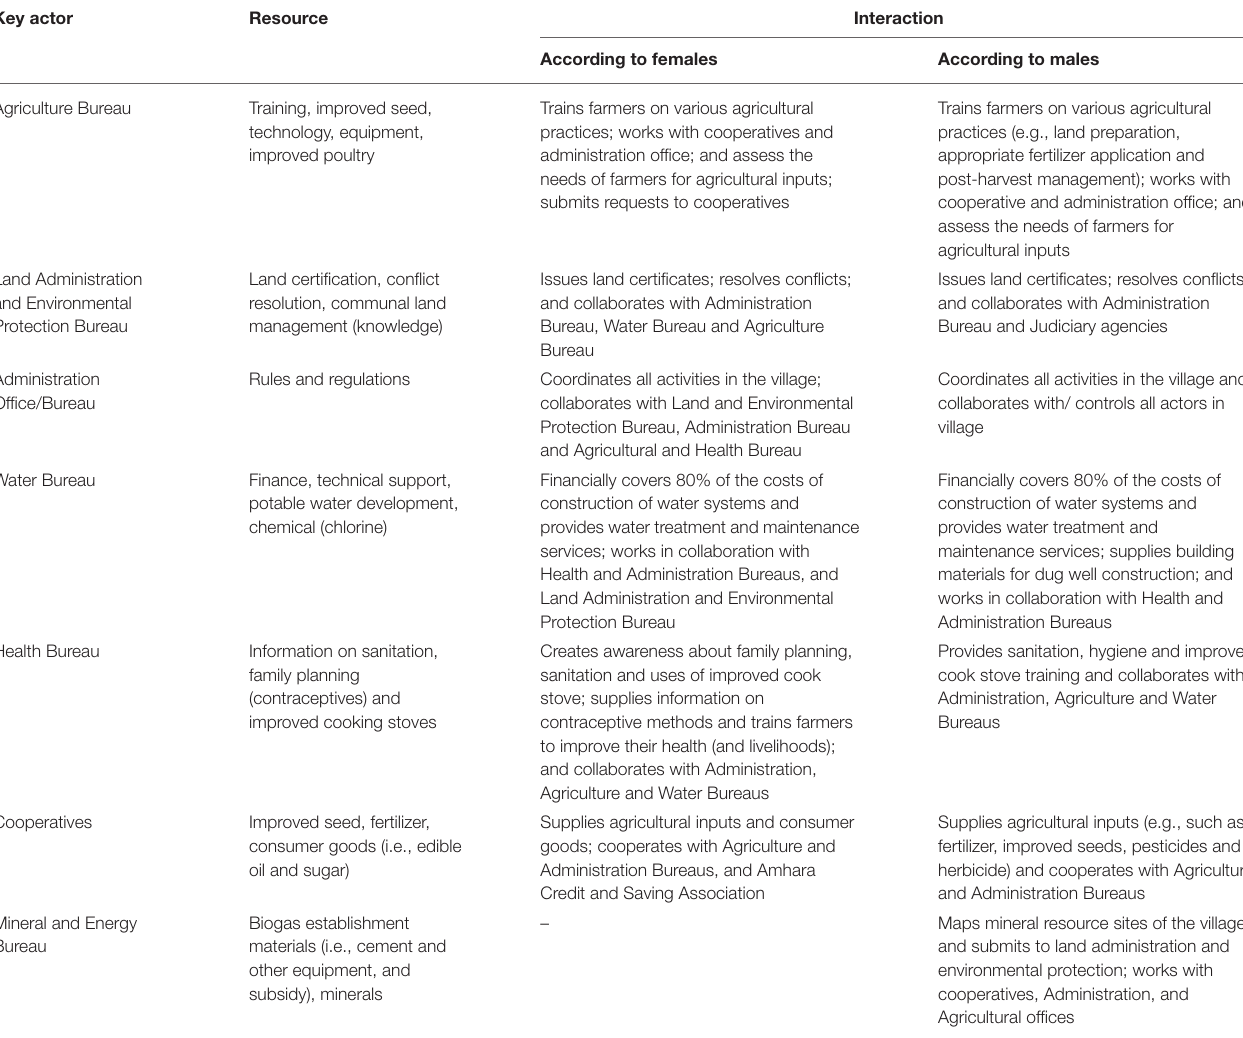
TABLE 2 | Direct actors, resources, and interactions identified by the female-only and male-only groups in the study area (Source: Own data). Key